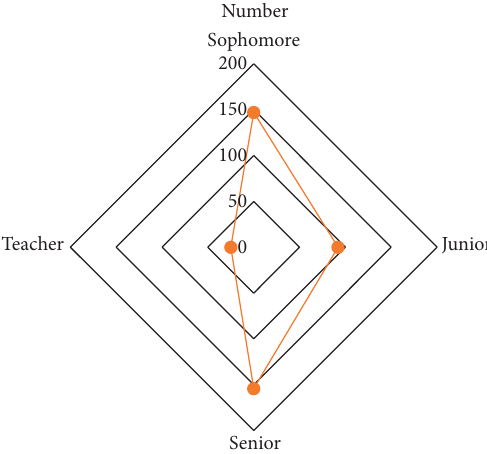
Figure 5: Basic information of